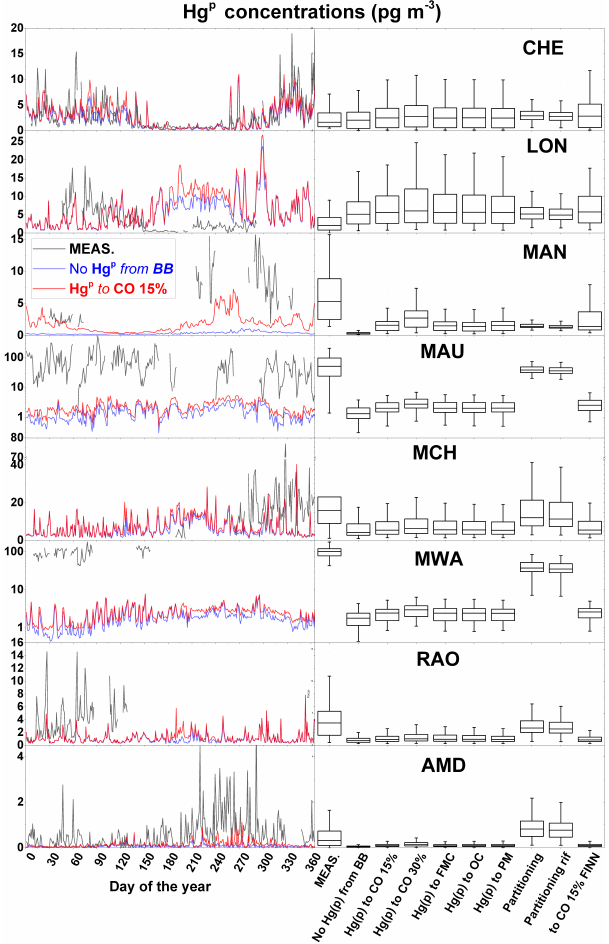
Figure 11. Left column: temporal evolution of the daily averaged surface Hg P concentrations measured at all sites from Table 2 for the entire 2013, compared with the modelled values as simulated by BASE and by NO Hg P runs, including emissions from all sources. Right column: box plots of the distribution of the of the daily aver- aged surface Hg P concentrations, for the entire 2013, as measured and simulated by the different sensitivity runs. Note the logarithmic for both MAU and MWA